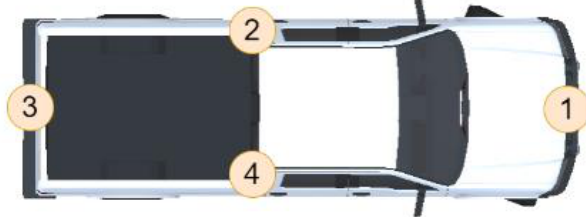
Figure 6. Tag placement for vehicle pose estimation.